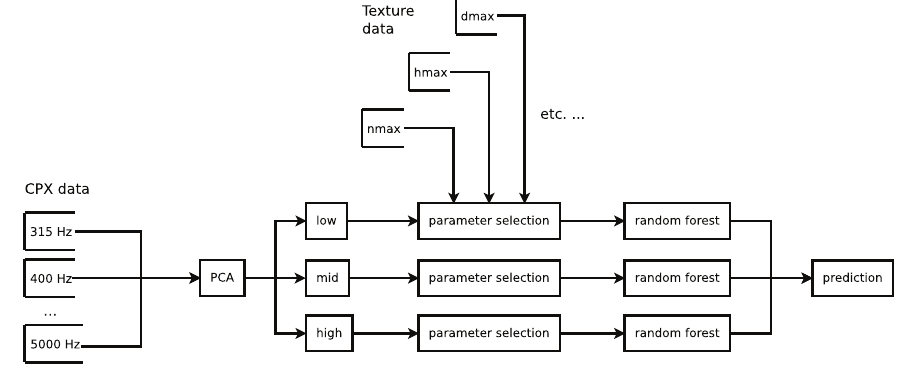
Figure 9. Block diagram of the multivariate modelling